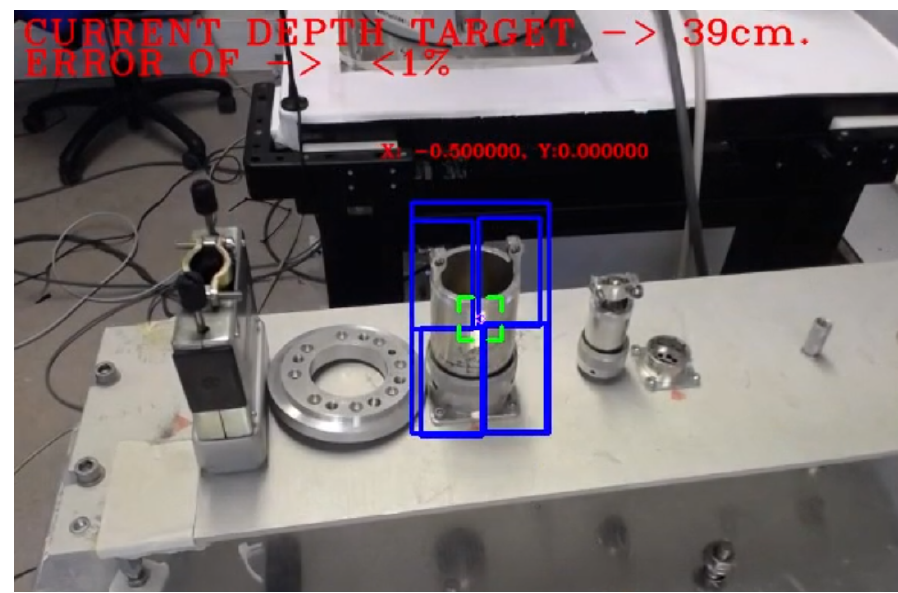
Figure 20. System execution, where the tracking and estimation is shown by